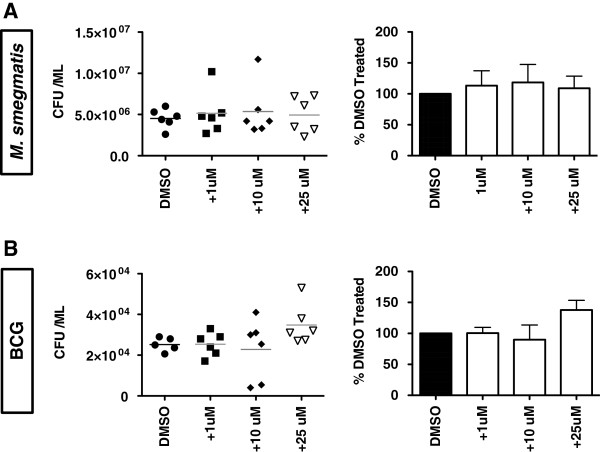
Rapamycin does not kill M. smegmatis or BCG in the absence of macrophages. M. smegmatis (A) or BCG (B) were cultured in DMEM + DMSO (control) or the indicated doses of Rapamycin. After 3 hours at 37C and 5% CO2, the wells were mixed and the bacteria were plated for CFU determination. On the left are the raw CFU values for each replicate. On the right is the percentage change (+/− SEM) from the mean value of cells treated with DMSO, which was set at 100%. For both (A) and (B), shown are the combined results of two independent assays.